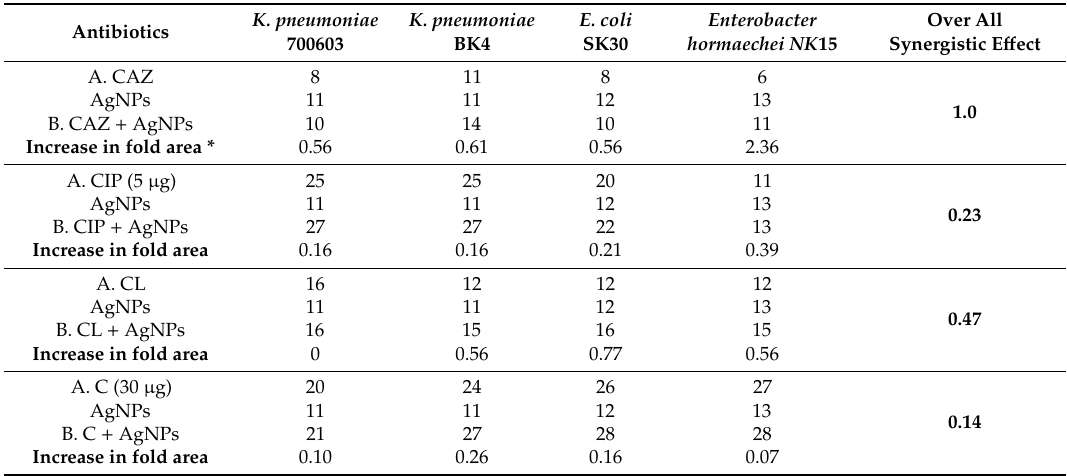
Table 2 . The zone of inhibition (mm) of different antibiotics alone and in combination with AgNPs against ESBL producing bacteria by disc diffusion method.